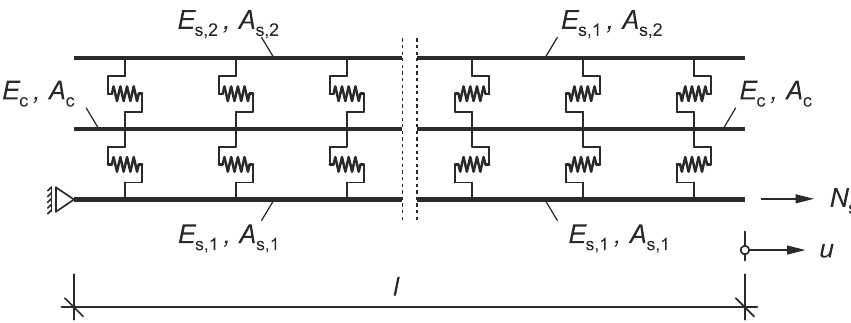
Figure 11. Extension of the CPM to a three-bar model.